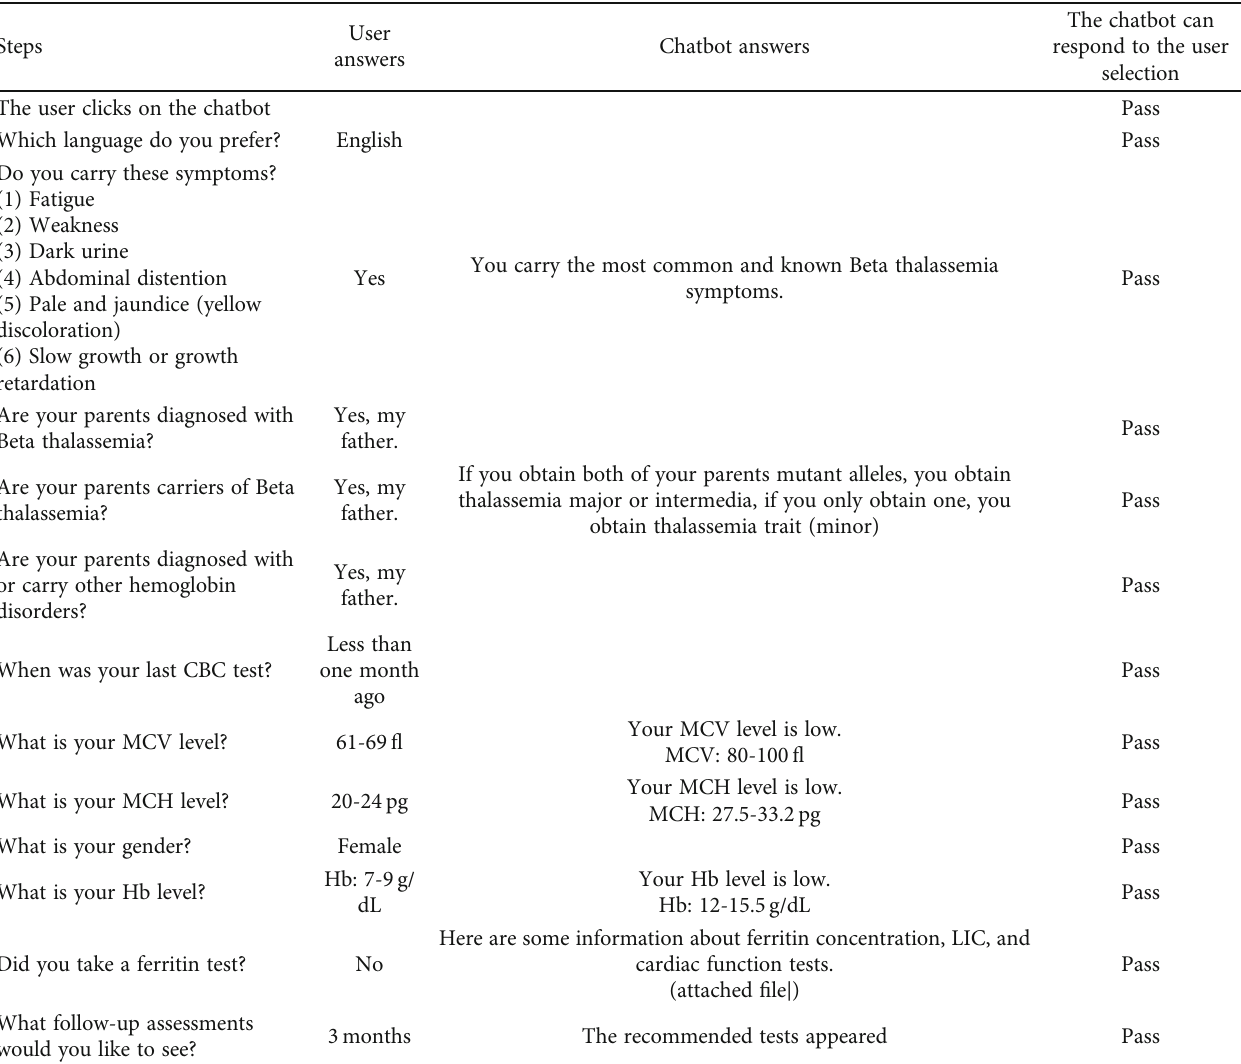
Table 2: Unit testing scenario for the